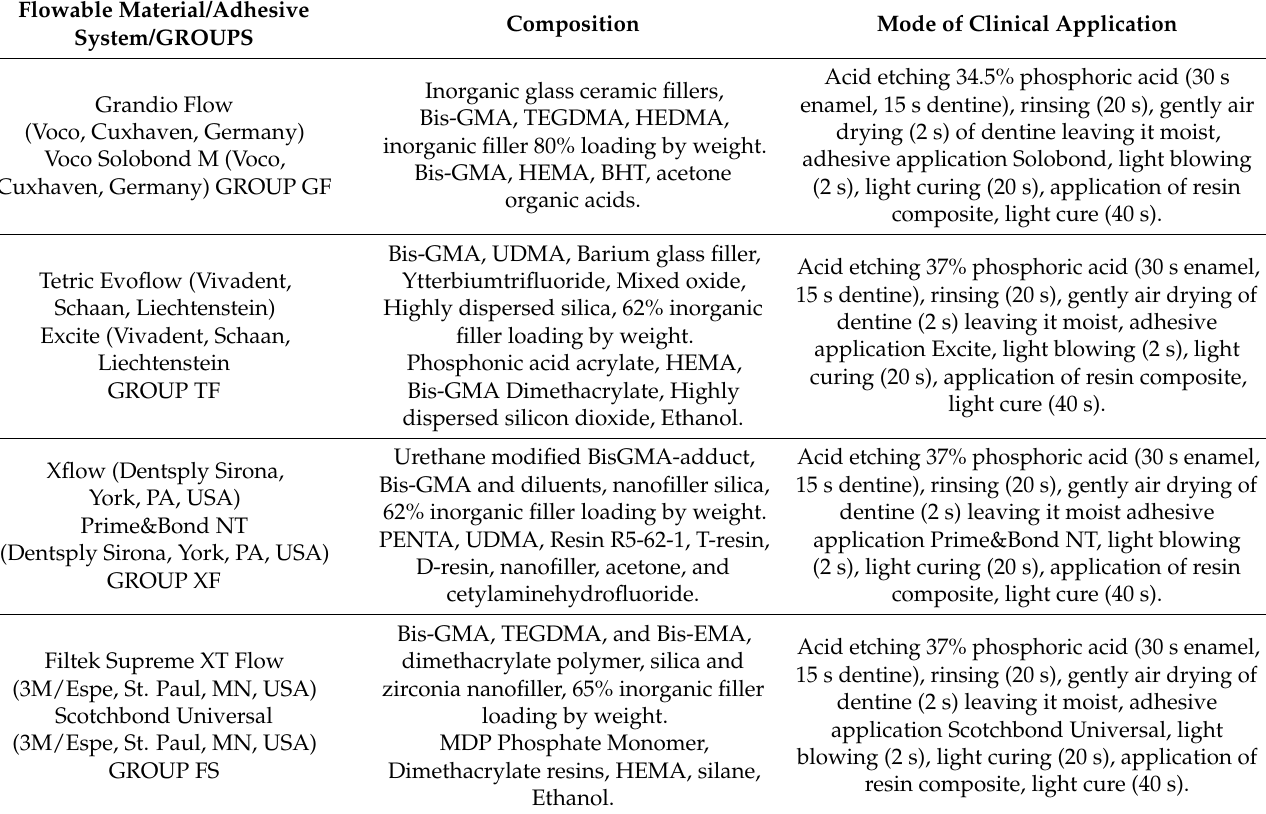
Table 1. Compositions of tested materials and the clinical mode of